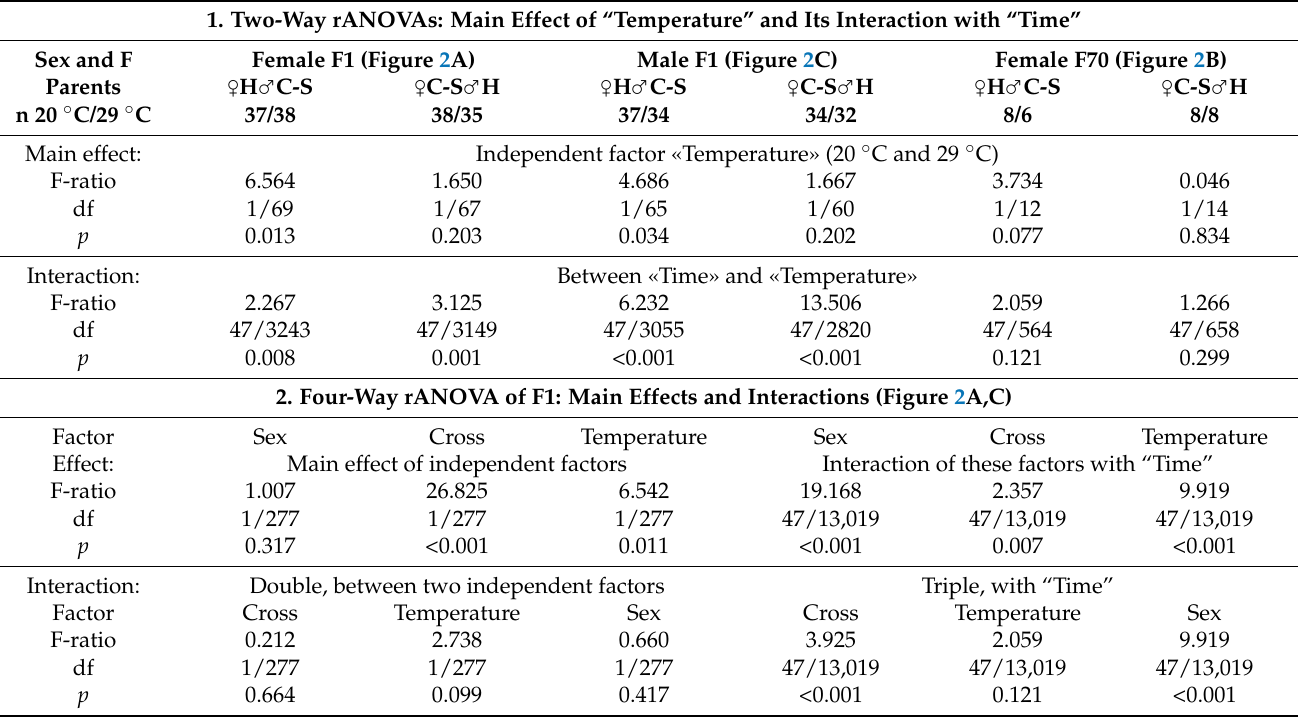
Table 2. 24-h sleep pattern: effects of independent factors and interactions (between them or with “Time”) 1. Two-Way rANOVAs: Main Effect of “Temperature” and Its Interaction with